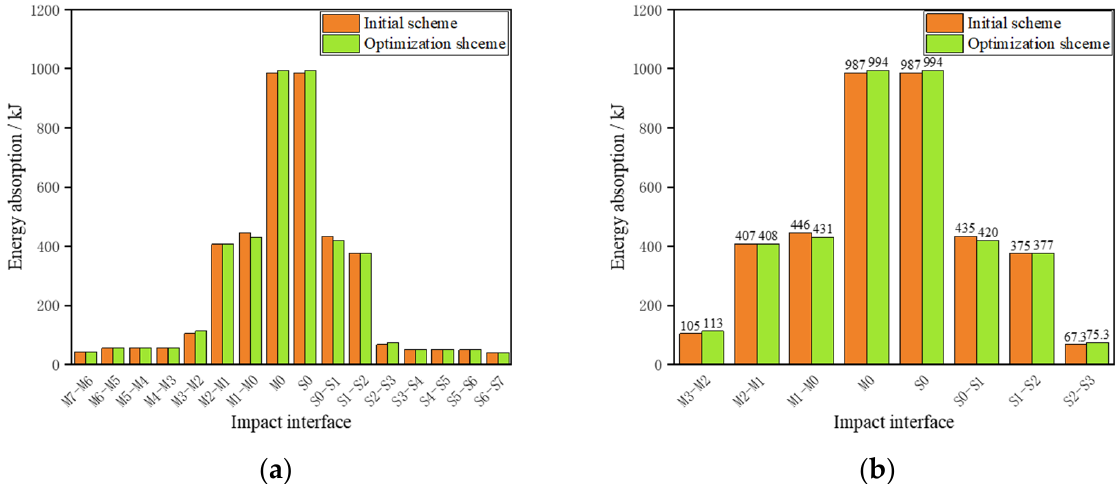
Figure 25. Comparison of energy distribution results before and after optimization: ( a ) all impact interfaces; ( b ) specific impact interfaces. Table 6. Comparison of results before and after optimization.